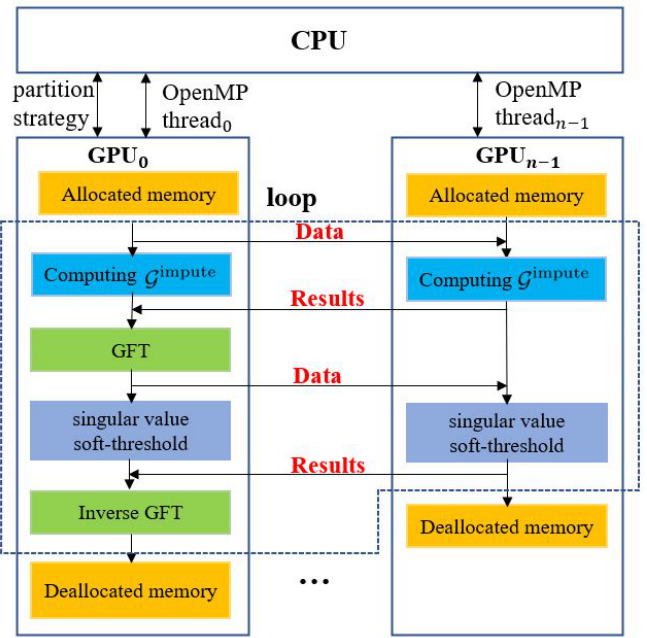
Figure 5. Multi-Graphics Processing Unit (GPU) scheme for the convolutional imputation